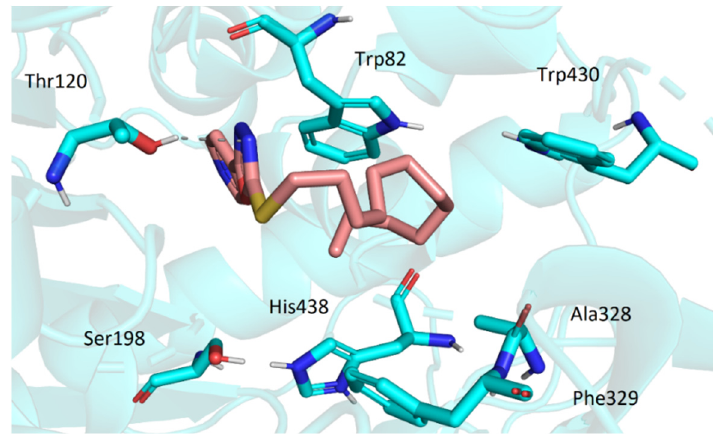
Figure 8. The conformation of 3s in the active site of